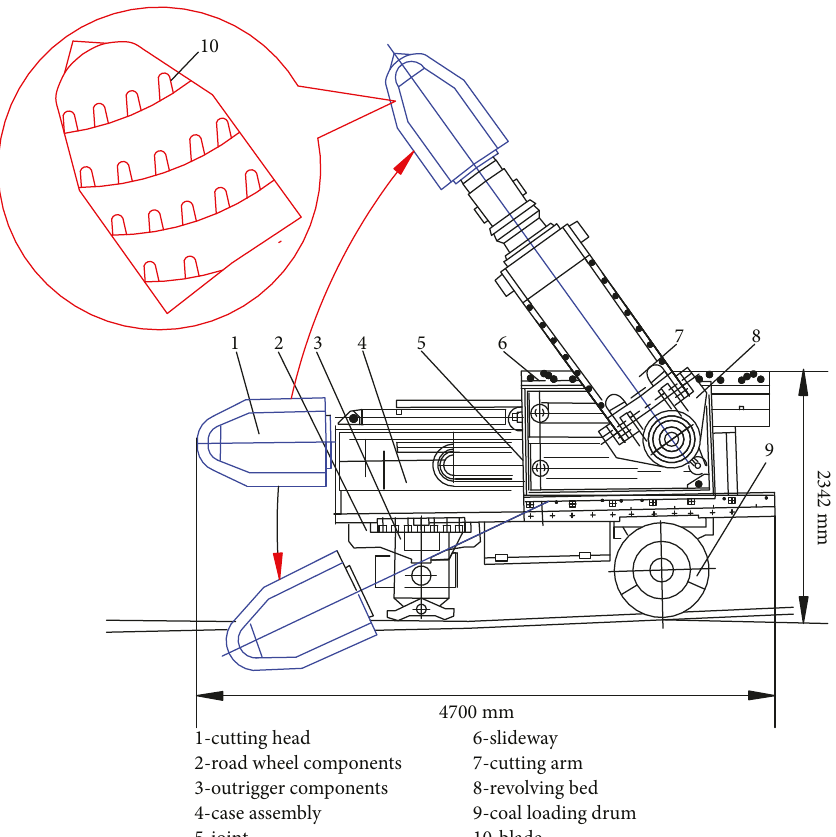
Figure 2: Components of the new roadheader-assisted coal